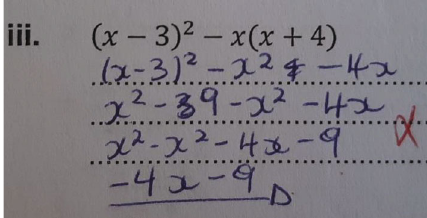
Figure 3: Control group learner B, School A.